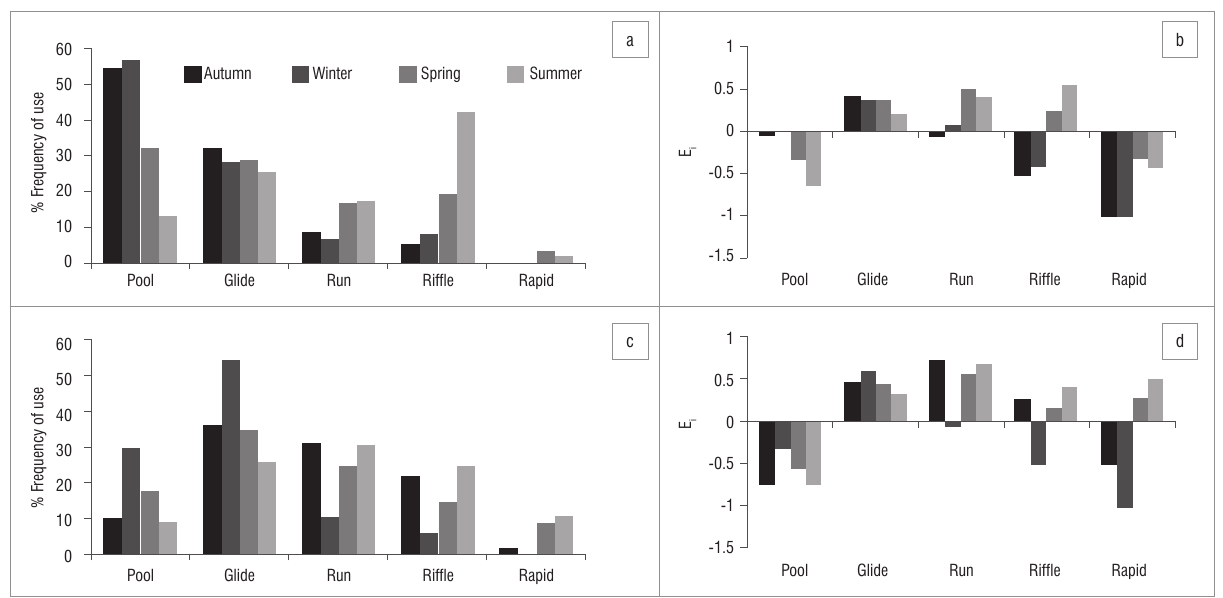
Figure 3: Percentage frequency of habitat biotope use by (a) Labeobarbus kimberleyensis and (b) L. aeneus in autumn, winter, spring and summer. Comparative Ivlev’s electivity index ( E ) scores for habitat use of (c) L. kimberleyensis and (d) L. aeneus in autumn, winter, spring and i